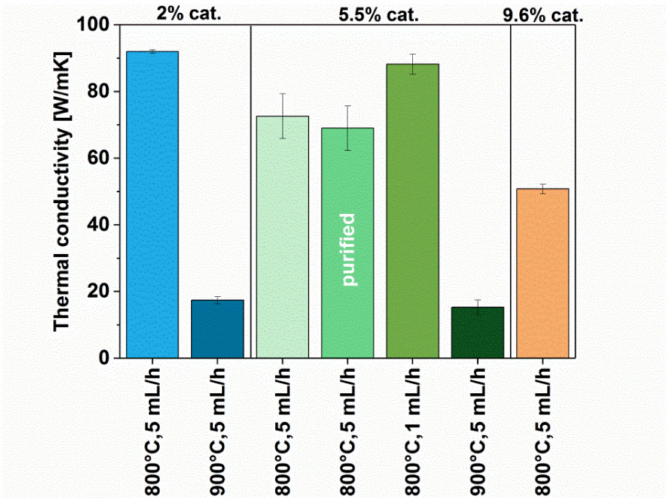
Figure 9. Thermal conductivity of MWCNTs synthesized using di ff erent parameters (with and without